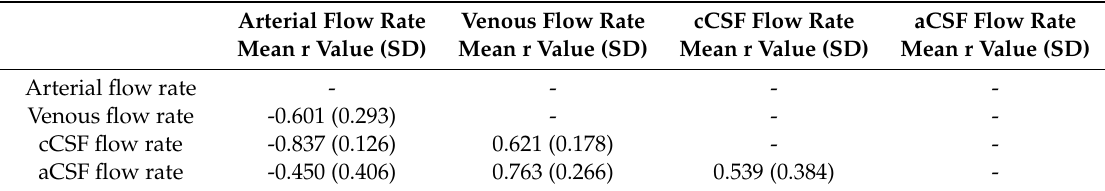
Table 3. Mean signal correlation r values for all the subjects aggregated together.